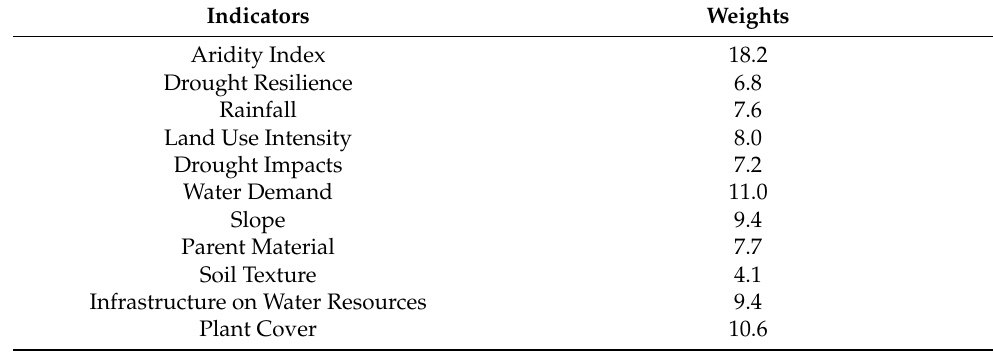
Table 3. WLDI Table 3. WLDI weights.